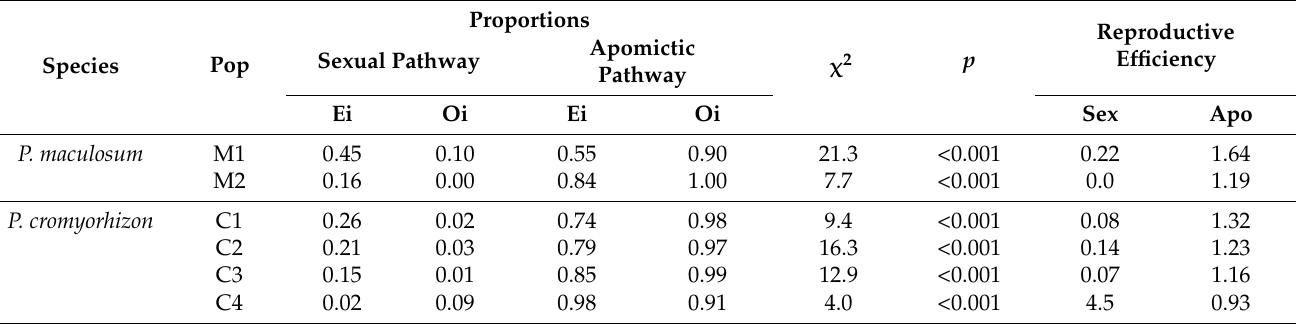
Table 5. Expected (Ei) and observed (Oi) proportions of sexuality and apomixis at the progeny stage and the reproductive efficiency of each